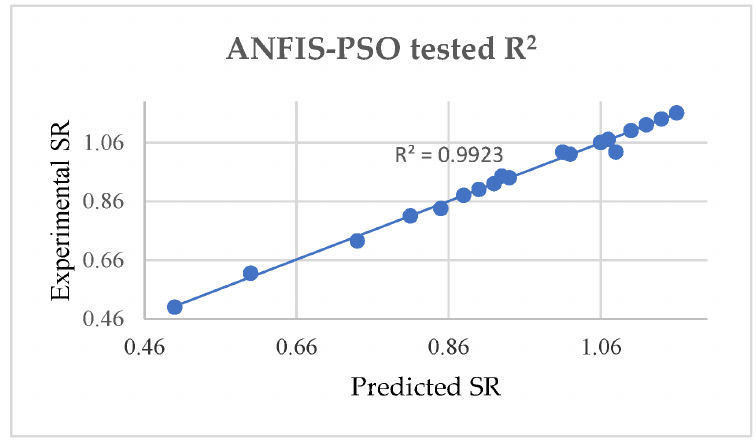
Figure 17. ANFIS-PSO trained regression line.